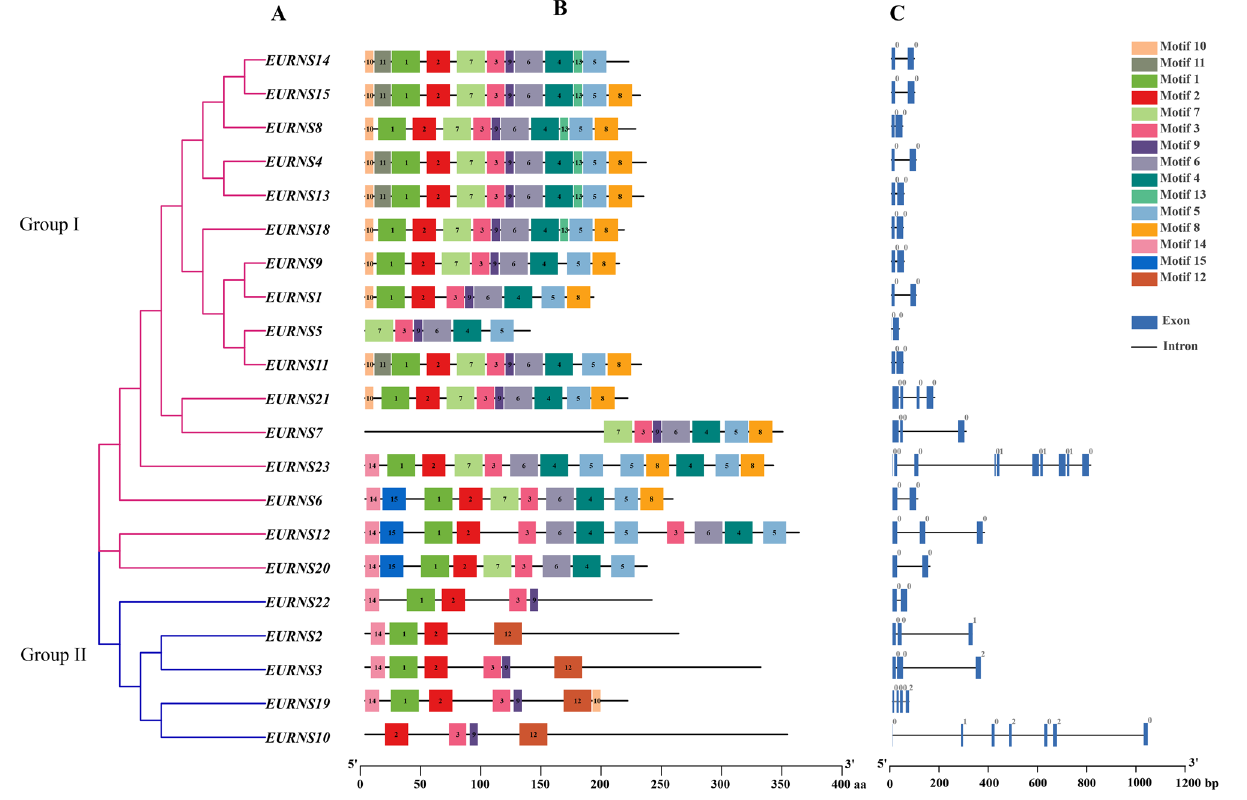
Figure 1. Phylogenetic relationships, architecture of conserved protein motif and gene structure of EURNS genes. ( A ) The phylogenetic tee was constructed based on the full-length of predicted proteins using MAGE X software. ( B ) The motif composition of EURNS proteins. Fifty motifs are displaced in different colored boxes, detail information showed in Figure S1. ( C ) Exon and intron structure of EURNS genes. Blue boxes indicates the exon; black lines indicate introns. The number indicates the phases of corresponding